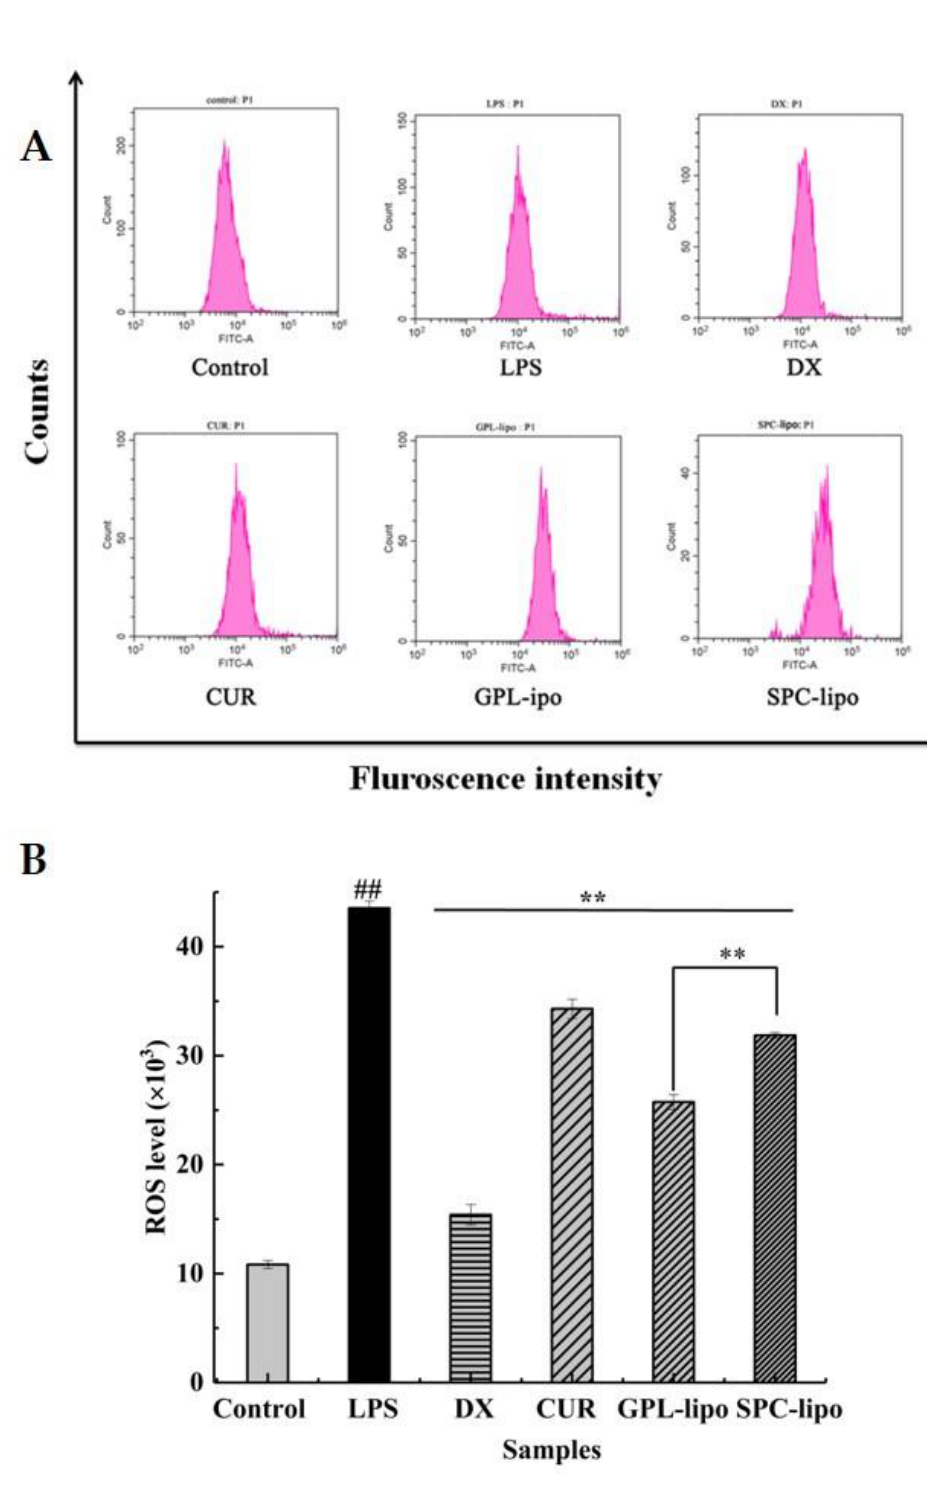
Figure 5. Effects of GPL-lipo and SPC-lipo on the reactive oxygen species (ROS) level in RAW264.7 cells ( A , B ). Data are expressed as mean ± SD ( n = 4) and multiple comparisons were done using one-way ANOVA analysis. ## p < 0.01 versus control group; ** p < 0.01 versus the LPS group. Abbreviations: DX-dexamethasone, GPL-golden pompano head phospholipids, SPC-soybean lecithin, CUR-curcumin, NO- nitric oxide, LPS-lipopolysaccharide.